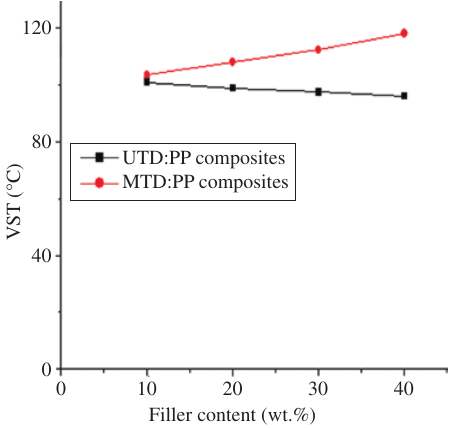
Figure 5: VST of TD:PP composites.